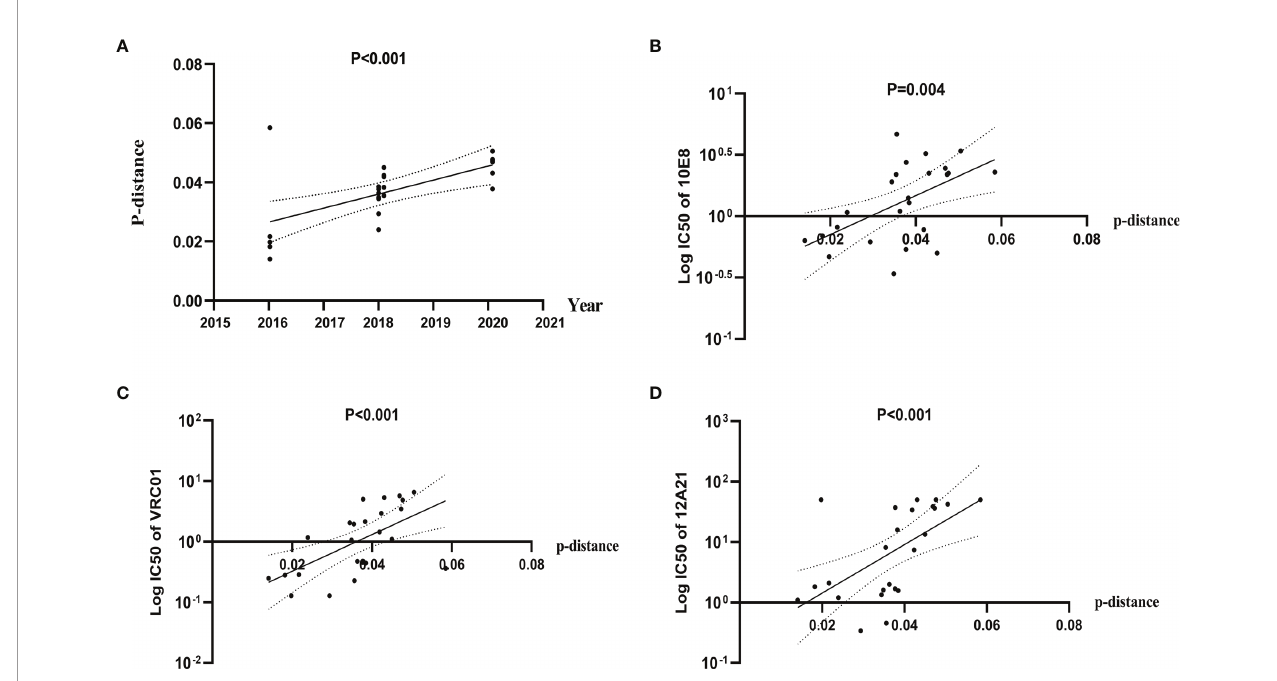
FIGURE 4 | Diversi fi cation of Env pseudovirus variants, over a period spanning 2016 to 2020, is associated with increased resistance to bNAbs. (A) Genetic distance between consensus sequence and pseudovirus sequence correlates with the calendar year and increases over time. Evolutionary divergence was estimated by distance matrix using MEGA software (Pearson correlation). (B – D) IC50 values of 10E8, VRC01, and 12A21 were positively correlated with distance, indicating an increase in resistance (Spearman correlation).